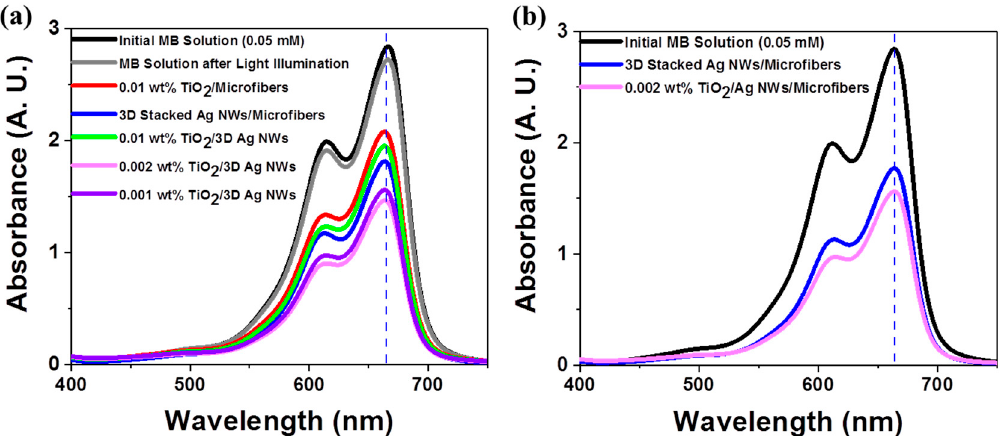
Figure 4. Photocatalytic performances of 0.05 mM methylene blue (MB) aqueous solutions after 10 min light illumination in the presences of different photocatalysts under ( a ) AM 1.5G simulated illumination and ( b ) visible and near-infrared illumination ( λ > 400 nm).